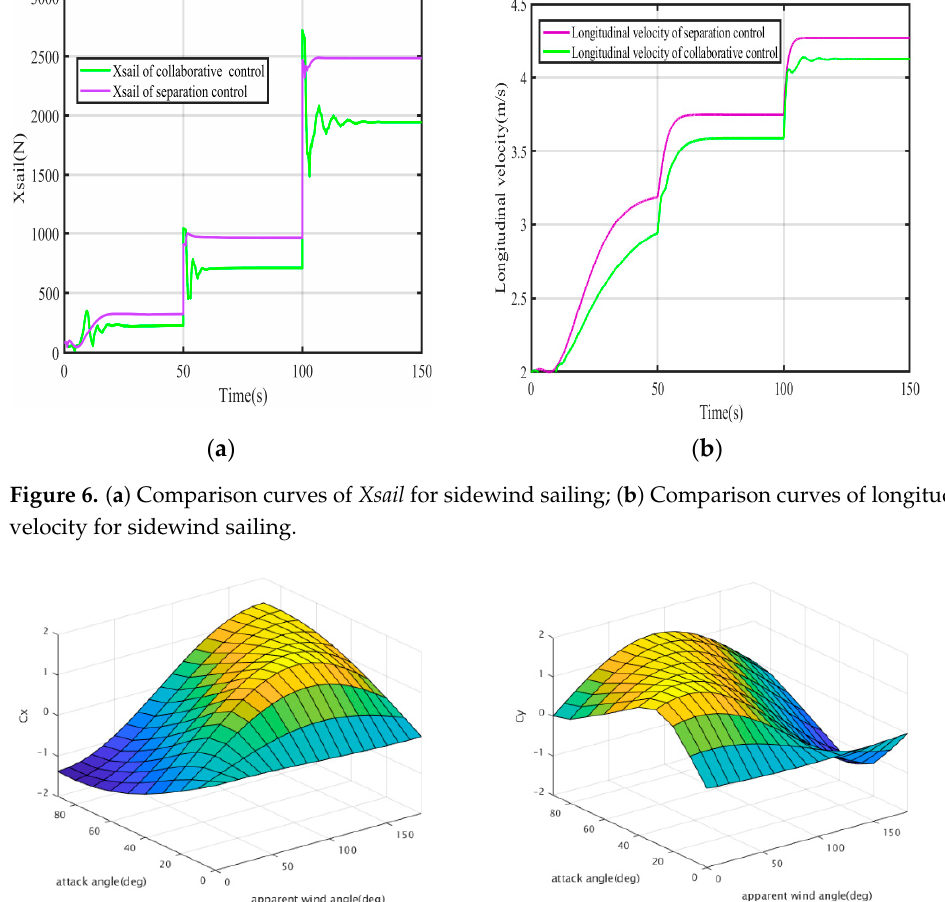
Figure 7. ( a ) Relationship among attack angle, apparent wind angle and Cx; ( b ) Relationship among attack angle, apparent wind angle and Cy. Table 4. Lateral speed and lateral displacement of the collaborative control and separation control.